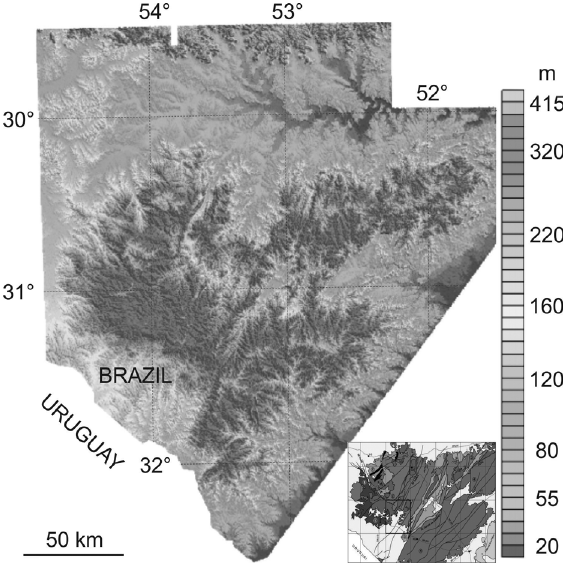
Figure 2 - Digital terrain elevation of study area. Large, red region in the center corresponds to higher elevations of the Sul- Riograndense Shield. Inset is the geological map of the studied region (Camozzato and Lopes 2012), indicating the major geotectonic units recognized in the shield. For interpretation of the references to color in this fi gure legend, the reader is referred to the web version of this